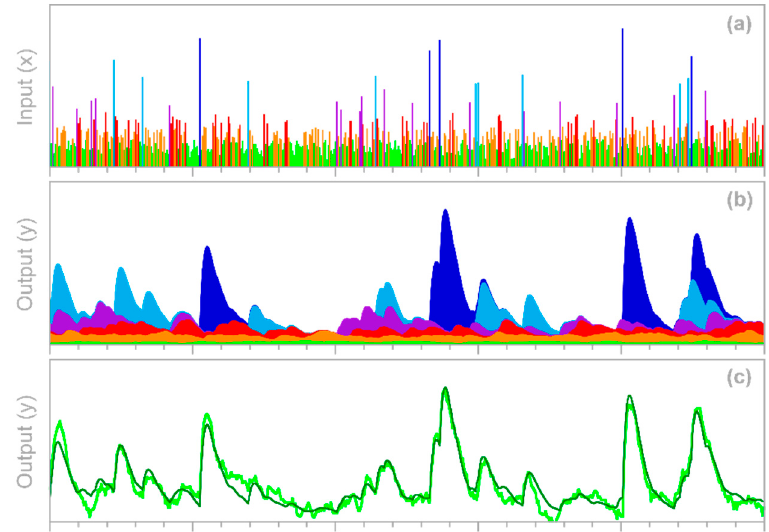
Figure 9. Example input and output time series for nonlinear deconvolution benchmark tests. The input is a log-normally distributed white noise time series, shown in ( a ) with different colors representing different ranges of values. Each value in ( a ) was convolved with a gamma distribution with shape factor of 2 and mean lifetime of 10, but with an amplitude proportional to the square of the input (thus yielding a system response that is proportional to the cube of the input). The resulting true output is shown in ( b ), with the same color coding as in ( a ) indicating the ranges of input values. The more numerous low-intensity inputs (e.g., green and orange) in ( a ) result in a relatively stable base output in ( b ), with the rarer but higher-intensity inputs (e.g., purple, light blue, and dark blue) generating markedly larger but more intermittent outputs. The combined true system output, shown by the dark green line in panel ( c ), was then corrupted by ARMA noise at a signal-to-noise ratio of 4, to yield the apparent system output shown by the light green line in panel ( c ). The plots shown here comprise 500 time steps, or 5% of the time series used for the benchmark tests.